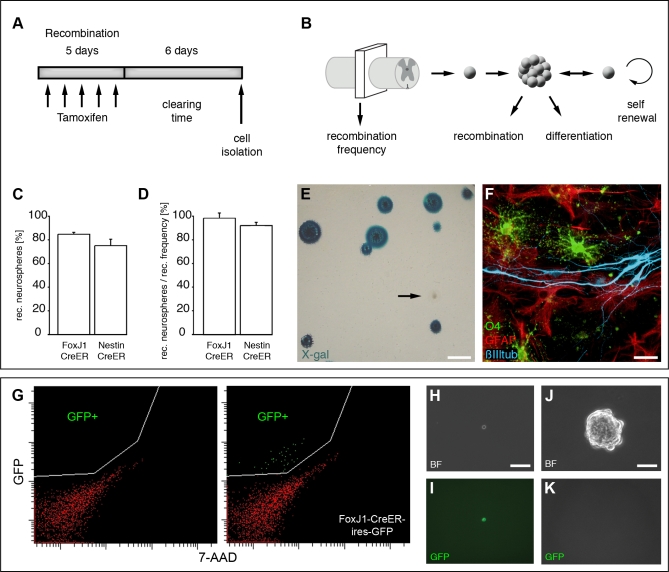
Ependymal Cells Display Neural Stem Cell Properties In Vitro(A) Schematic depiction of tamoxifen administration paradigm and (B) analysis of neural stem cell properties and in vivo and in vitro recombination frequency.(C) The high proportion of recombined (rec.) neurospheres (mean + SD, n = 6 mice for each transgenic mouse line) demonstrates that the majority derives from ependymal cells.(D) Estimate of the proportion of neurospheres that derive from ependymal cells by normalization to the recombination rate in tissue sections of the spinal cords that were used to initiate the cultures (mean ± SD).(E) Recombined primary neurospheres from FoxJ1-CreER mice on R26R background visualized by X-gal staining (arrow points to one unrecombined neurosphere).(F) Differentiation of a clonally derived recombined neurosphere into neurons (βIIItub), astrocytes (GFAP), and oligodendrocytes (O4).(G) Flow cytometric isolation of GFP+ cells from the spinal cord of adult FoxJ1-CreER mice based on the IRES-GFP signal (GFP gate). 7-AAD labels dead cells, which were excluded.(H–K) Brightfield (BF) and fluorescent images (I and K) of a single GFP+ sorted cell and a neurosphere (J) formed from such a cell, which is GFP− due to the lack of FoxJ1 expression (K).Scale bars indicate 400 μm in (E), 20 μm in (F), 100 μm in (H) and (I), and 50 μm in (J) and (K).